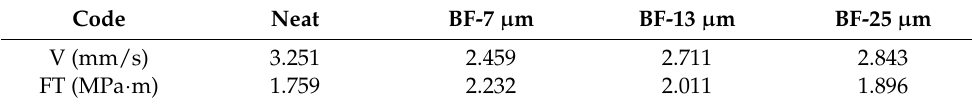
Table 4. Average crack propagation rate and fracture toughness test results.